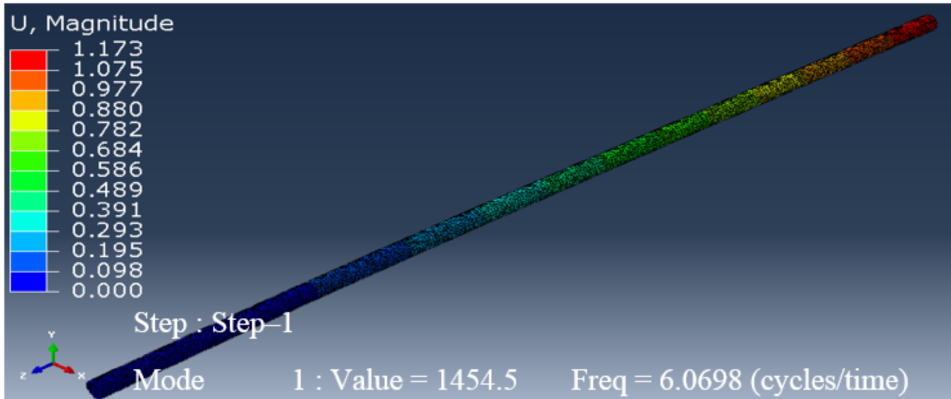
Figure 3. First natural frequency of an undamaged